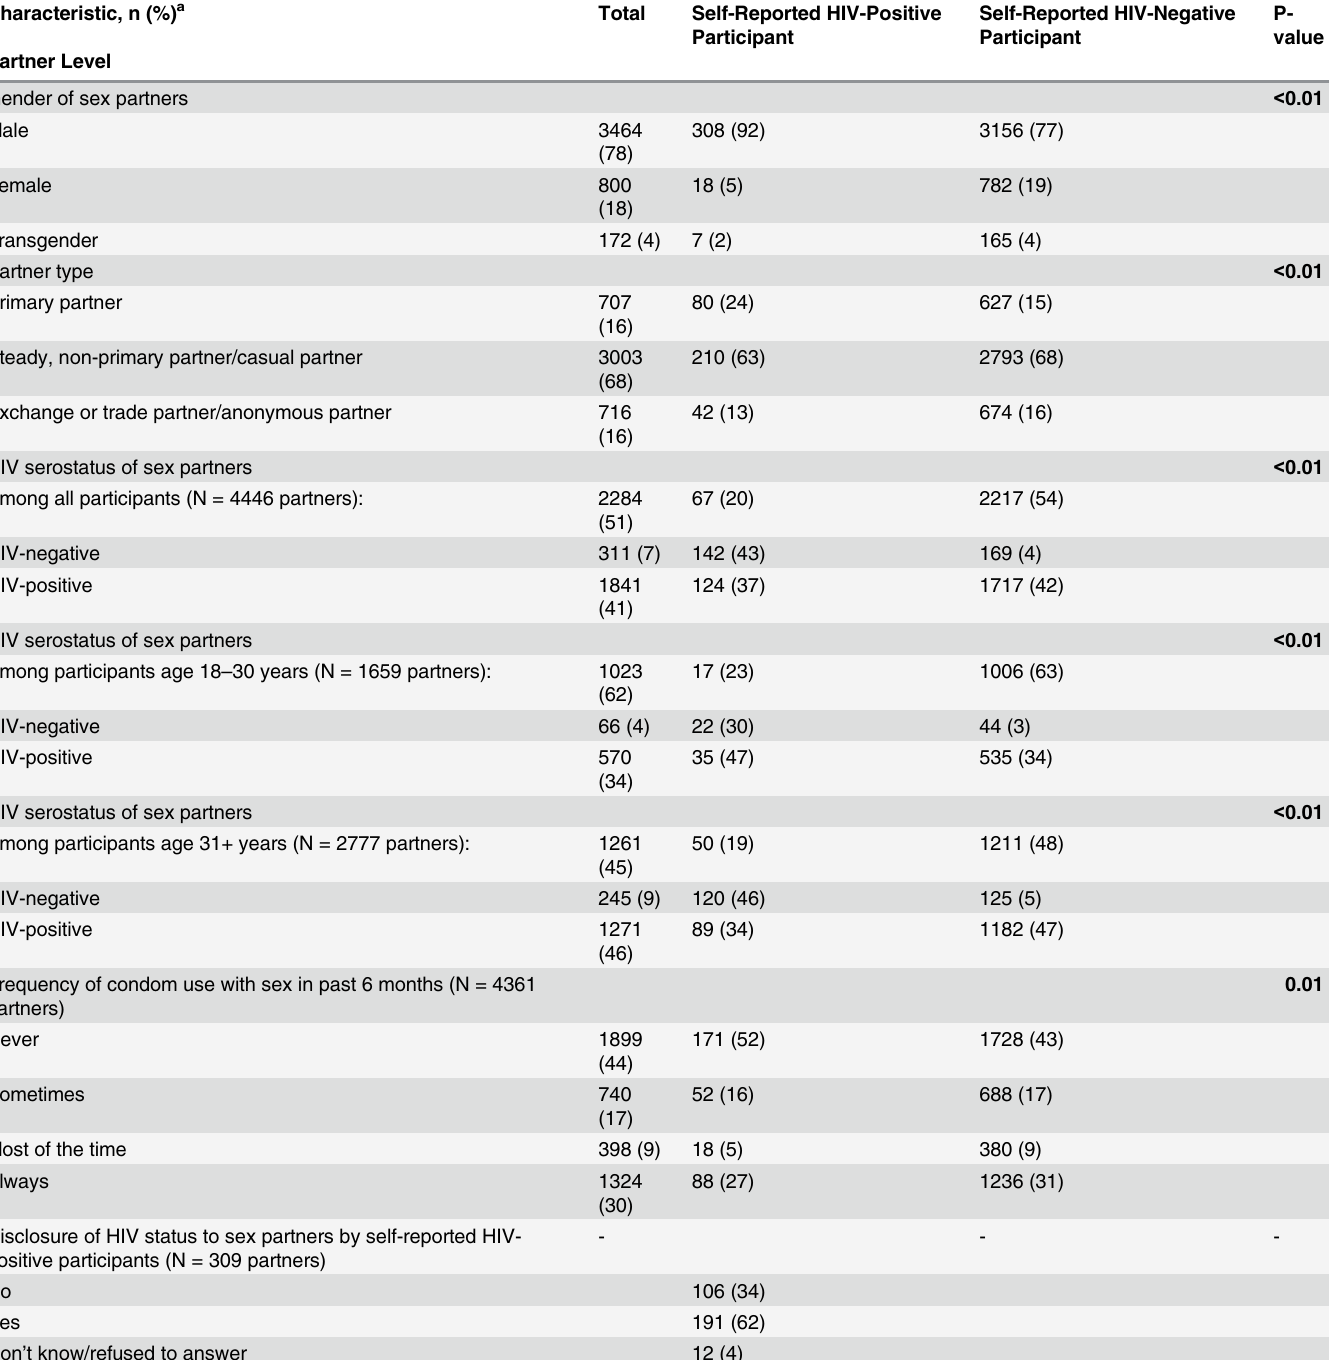
Table 2. Sex Partner Characteristics, Condom Use, and HIV Serostatus Disclosure of Community-Recruited Black MSM, Partner-Level Data (N = 4,449 Partners). Characteristic, n (%)